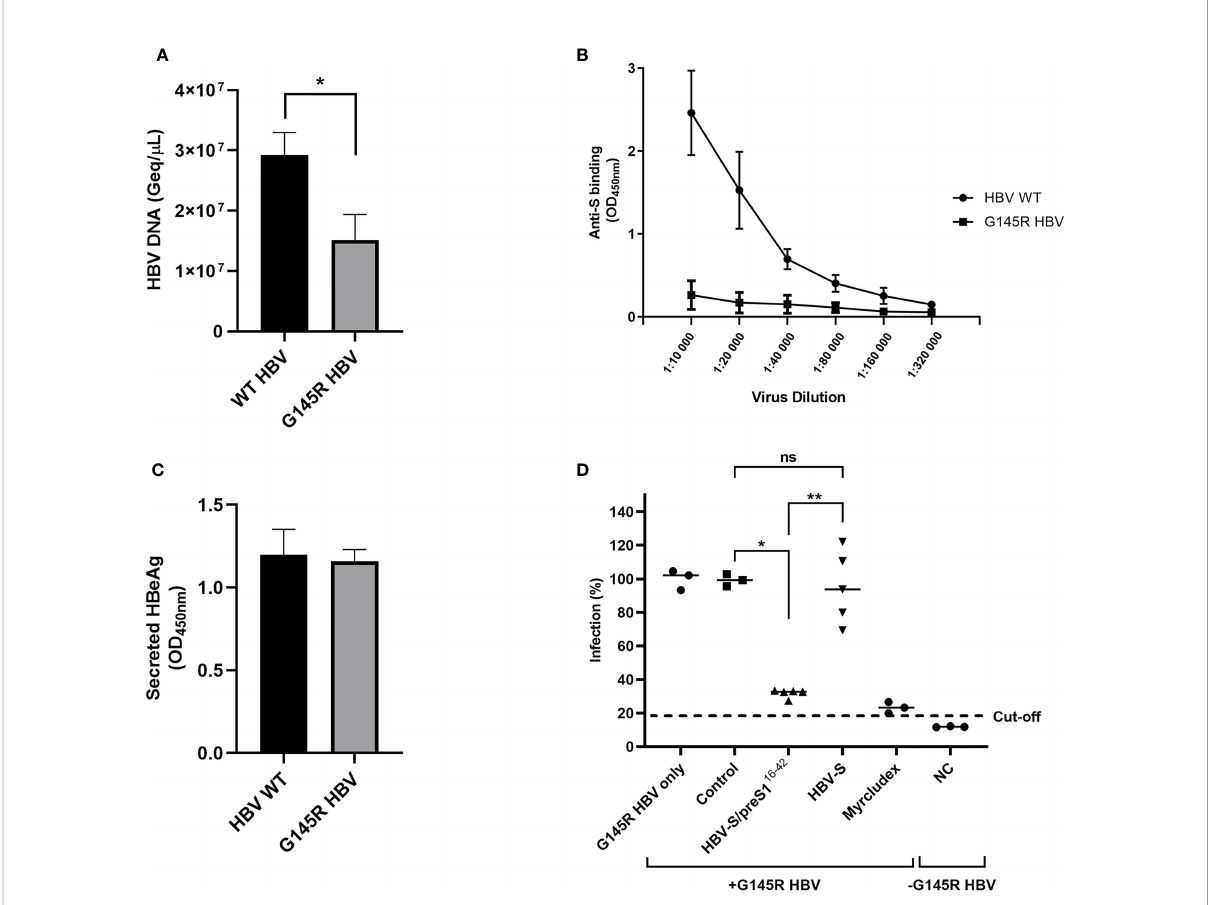
FIGURE 9 Neutralization of G145R HBV infection by S and S/preS1 16-42 antisera. (A) Huh7 cells were transfected with pGEM-4Z-HBV 1.3 WT or pGEM-4Z- HBV 1.3 G145R. Secretion of HBV particles was quanti fi ed in cell media by qPCR at day 7 post-transfection (n=4). Data are represented as means ± SD; Student ’ s unpaired t test (*, p < 0.05). (B) Serial dilutions of WT and G145R HBV particles were incubated with anti-S antibodies and speci fi c binding was quanti fi ed by using the Monolisa HBsAg Ultra kit. Results are shown as optical density values measured at 450 nm (n=3). Data are represented as means ± SD. (C) HepG2 hNTCP cells were incubated with WT and G145R HBV particles (100 Geq/cell) for 16 h in the presence of 4% PEG. At 16 h post-infection the medium was supplemented with 2.5% DMSO, then changed every two days. Cell media were collected at day 11 post-infection and used to quantify the HBeAg levels by ELISA. Results are shown as optical density values measured at 450 nm (n=3). Data are represented as means ± SD. (D) Pooled pre-immune sera or sera from mice immunized with S, S/preS1 16-42 , or background proteins (control) were diluted 1:50 and pre-incubated with G145R HBV inoculum (100 Geq/cell), in medium supplemented with 4% PEG, for 1 h. HepG2 hNTCP cells were incubated with the sera-treated HBV inoculum for 16 h, or maintained non-infected, as negative control (NC). Cells incubated with Myrcludex B for 3 h prior to infection were used as a control for the speci fi city of inhibition of HBV infection. At 16 h post- infection the medium was supplemented with 2.5% DMSO and then changed every two days. Cell media were collected at day 11 post-infection and used to quantify the HBeAg levels by ELISA. Data are shown as percentage of HBV infection in the presence of post-immune sera from values obtained in the presence of the pre-immune sera, at the same dilution (n=5). Values in the presence of Myrcludex and in the negative- control represent percentages of infection from G145R HBV-only samples (n=5). Statistical analysis was performed by using the Mann-Whitney U test. Comparisons between control and either antigen groups and between the antigen groups are shown (*, p < 0.05; **, p < 0.01; ns, no statistical signi fi